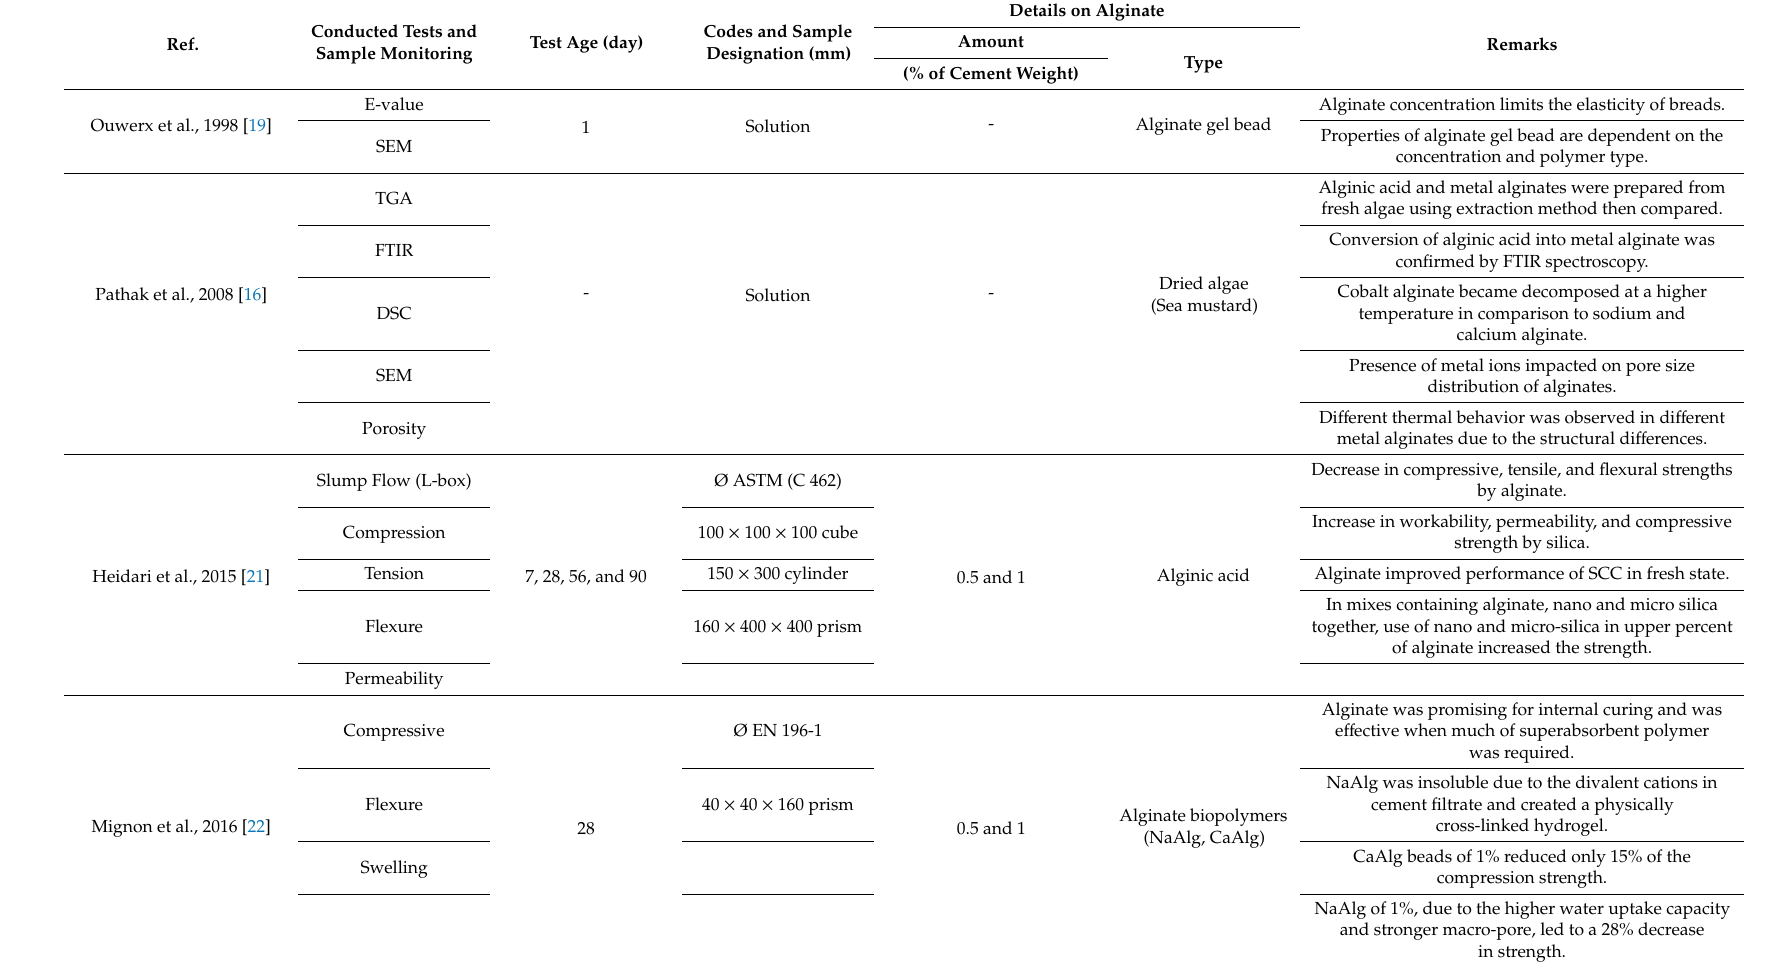
Table 2. Alginate application in